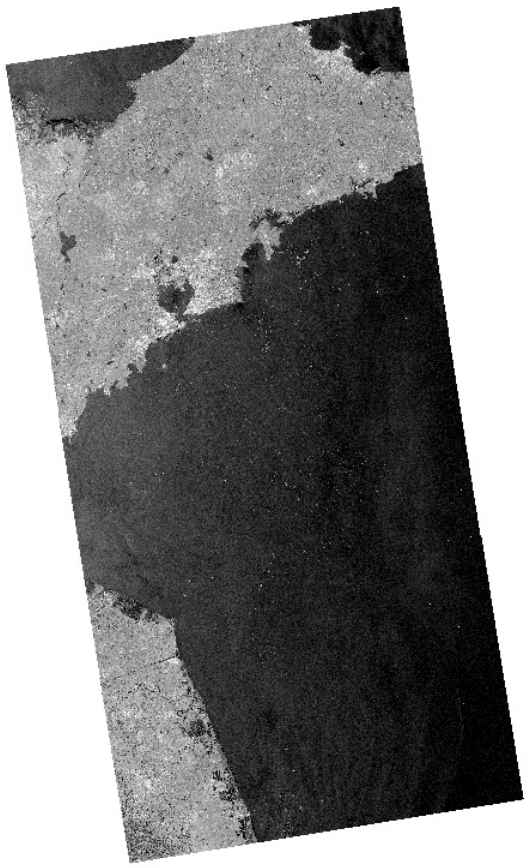
Figure 9. The SAR image of the South Yellow Sea area on 12 July 2021 after preprocessing.